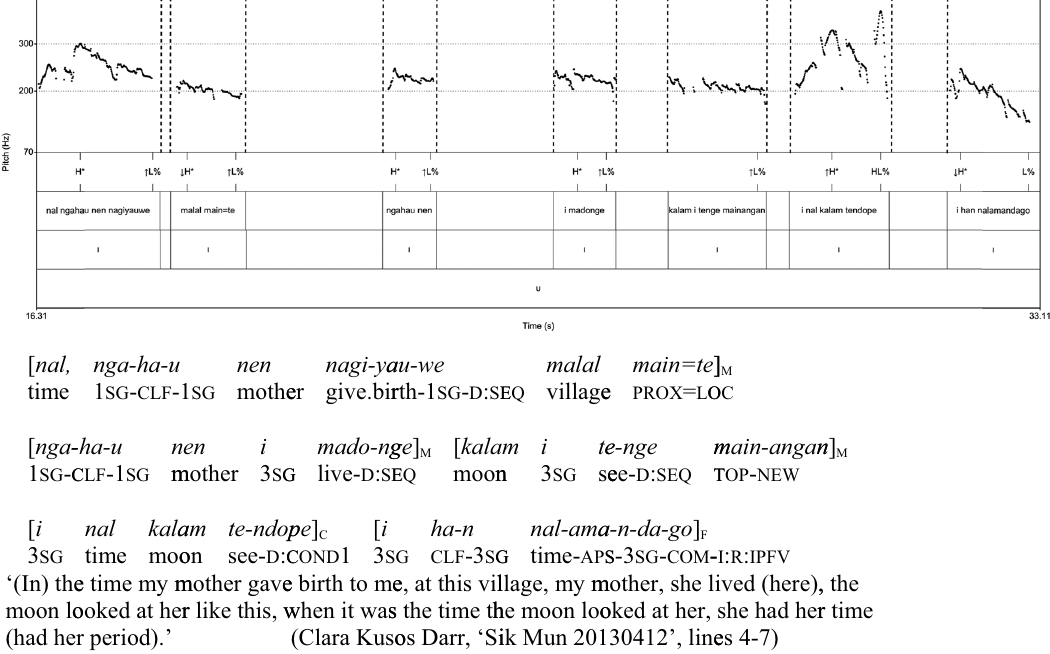
Figure 6: Clause chain with medial ↑ L% tones and fi nal L%